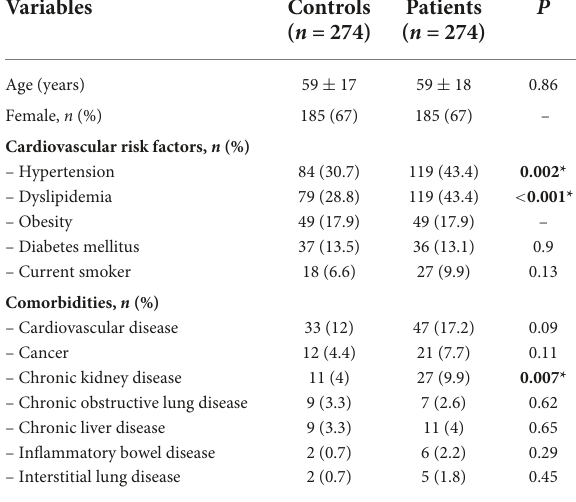
TABLE 1 Underlying diseases and immunosuppressive therapy in 274 patients with inflammatory rheumatology diseases complicated with coronavirus disease 2019 (COVID-19).